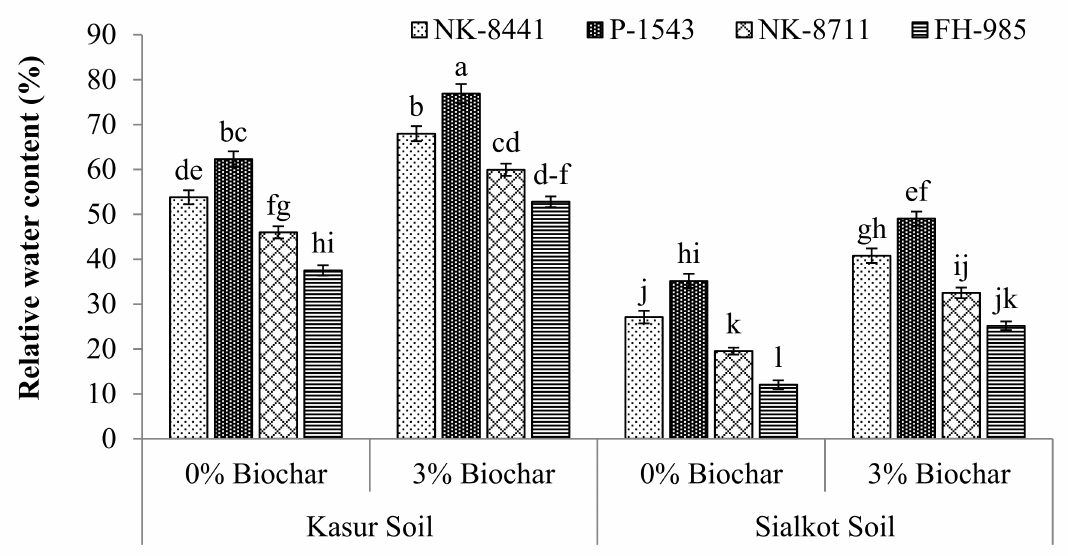
Figure 1. Relative water content of studied maize cultivars with the application of biochar in the tannery polluted soils of Kasur and Sialkot. Mean values are indicated by the columns and the standard error of the mean is shown with bars. All means followed by different letters are significantly different ( p < 0.05) according to Tukey’s HSD test.